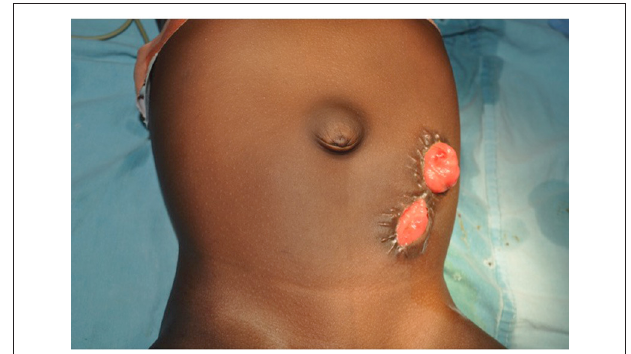
FIGURE 3 | A divided distal descending/sigmoid colostomy in a girl with anorectal malformation.